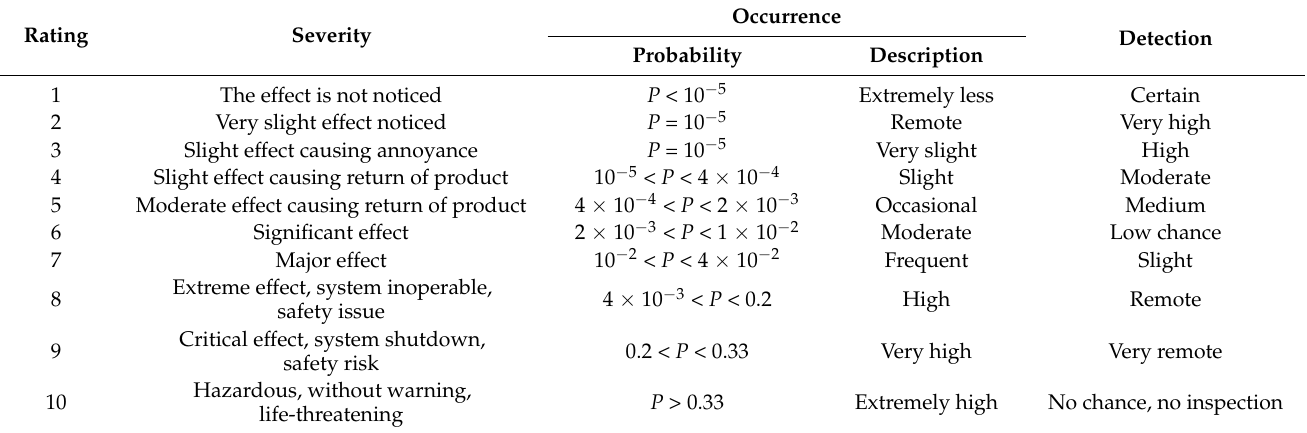
Table 3. The rating guidance of severity, occurrence, and detection